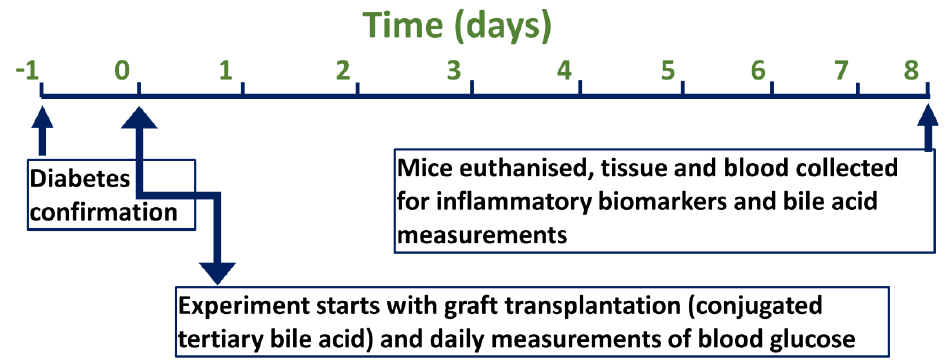
Figure 2. Study design and time – event series of experiments.